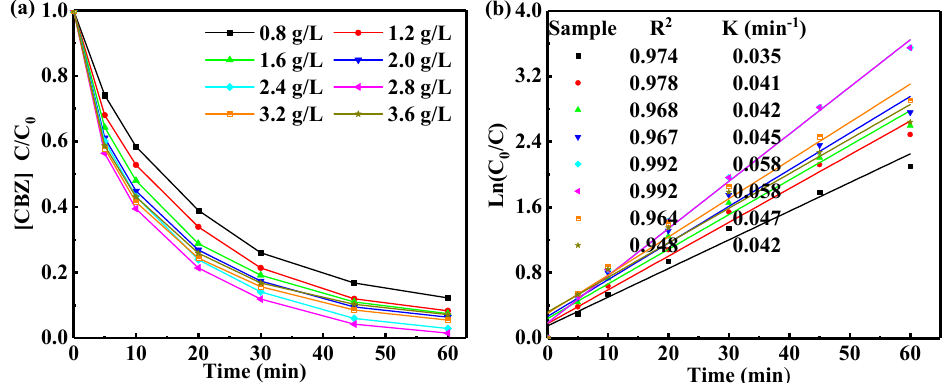
Figure 7. ( a ) Degradation of CBZ by UV-LED / TiO 2 using di ff erent concentrations of nano-TiO 2 ( b ) The pseudo-first-order kinetic models of CBZ degradation by UV-LED / TiO 2 using di ff erent concentrations of nano-TiO 2 . C(CBZ) 0 = 18.8 µ M; operating temperature = 20 ◦ C; wavelength of UV-LED = 365 nm; I 0 = 774 µ W / cm 2 : and operating pH =